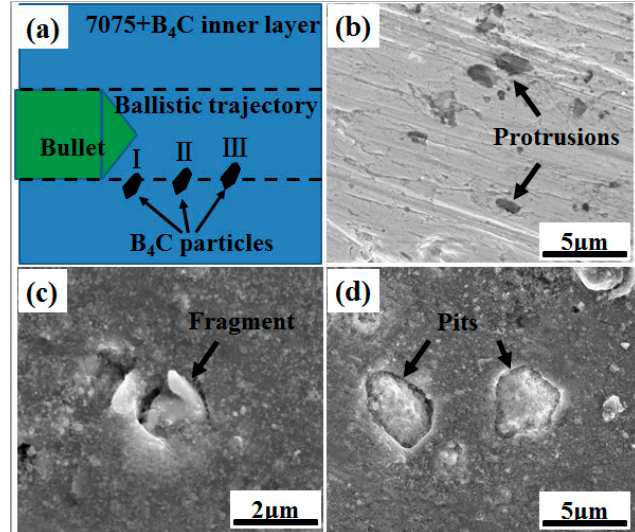
Figure 8. ( a ) Schematic of the possible positions of B 4 C particles on the bullet penetrating direction, ( b ) protrusions of B 4 C particles, ( c ) fragment of B 4 C particles, and ( d ) pits induced by the B 4 C particles falling off the surface of the ballistic trajectory.